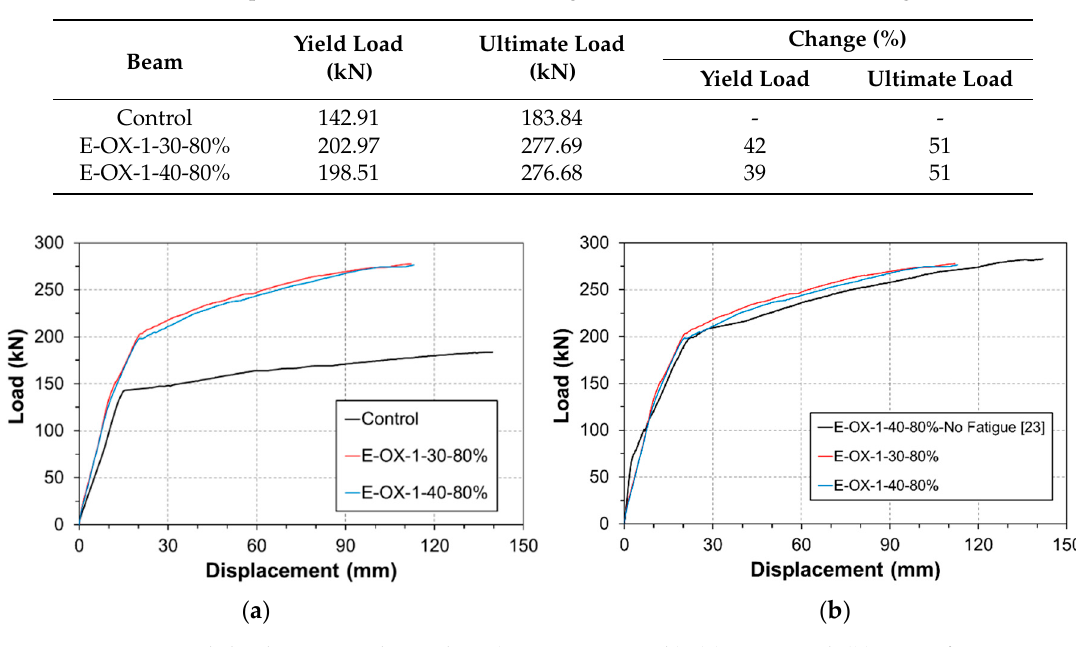
Figure 6. Load-displacement relationships (Concrete strength): ( a ) vs. control; ( b ) vs. no fatigue.